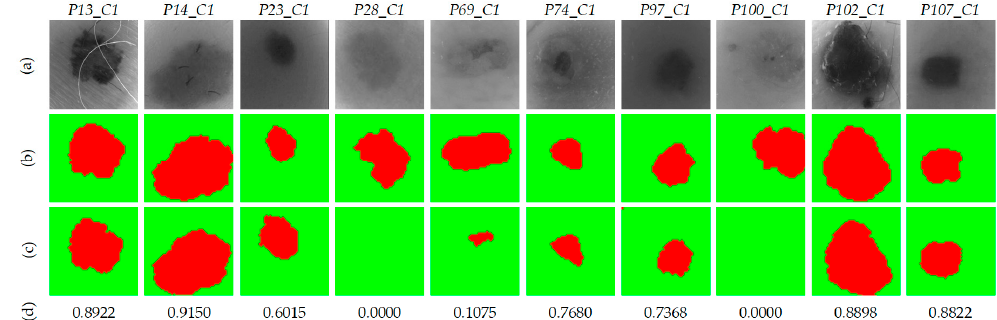
Figure 13. Two-class segmentation maps of the test database using per pixel method with K = 7. ( a ) Gray-scale images. ( b ) Ground-truth maps. ( c ) Results with morphological post-processing. ( d ) Jaccard coefficient values of the results with morphological post-processing.